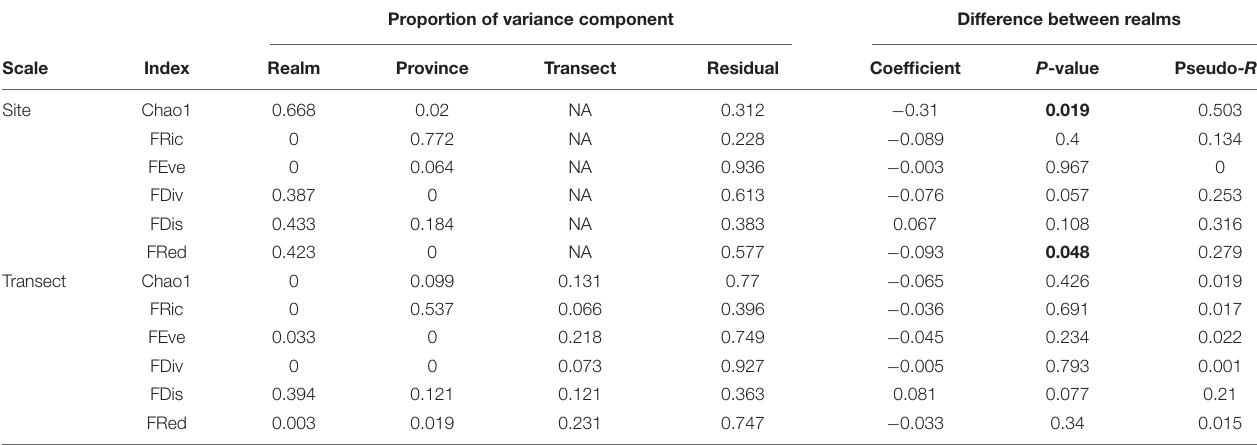
TABLE 2 | Summary of linear mixed models for species richness (Chao 1 index) and functional diversity at the two spatial scales of analysis. Proportion of variance component Difference between